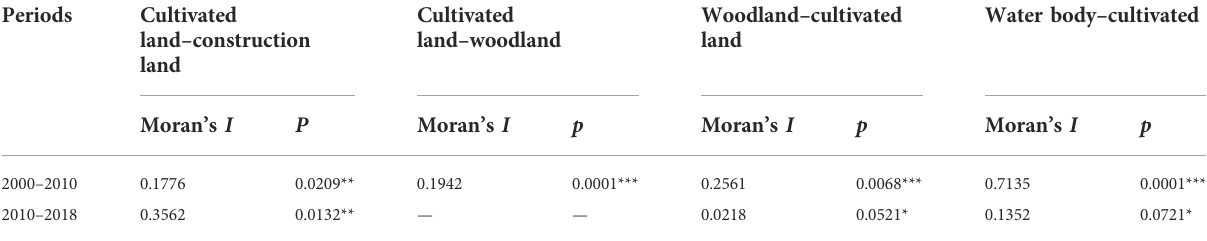
TABLE 5 Global Moran ’ s Index of the main land type transitions in different phases. Periods